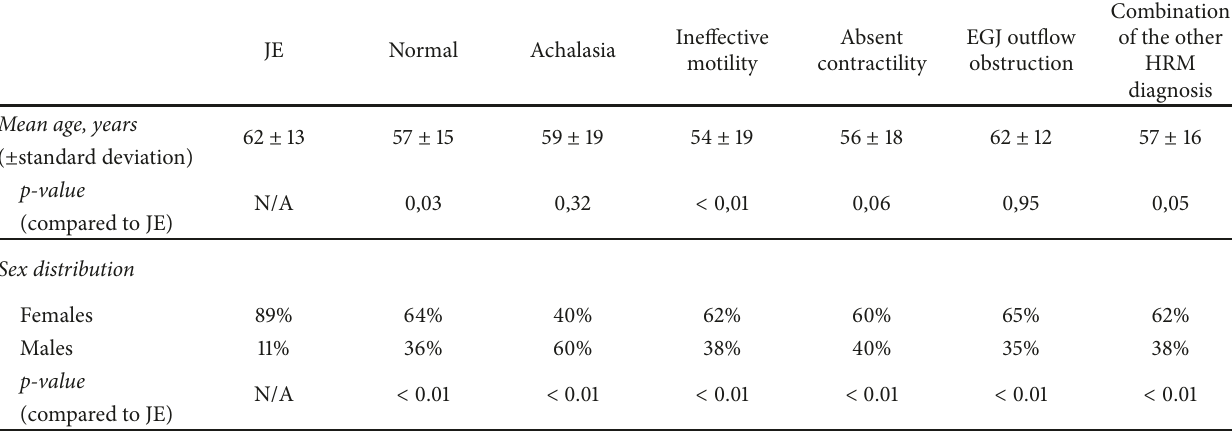
Table 2: Comparison of age and sex distribution of the patients with Jackhammer esophagus (JE) and the other motility disorders diagnosed during HRM.